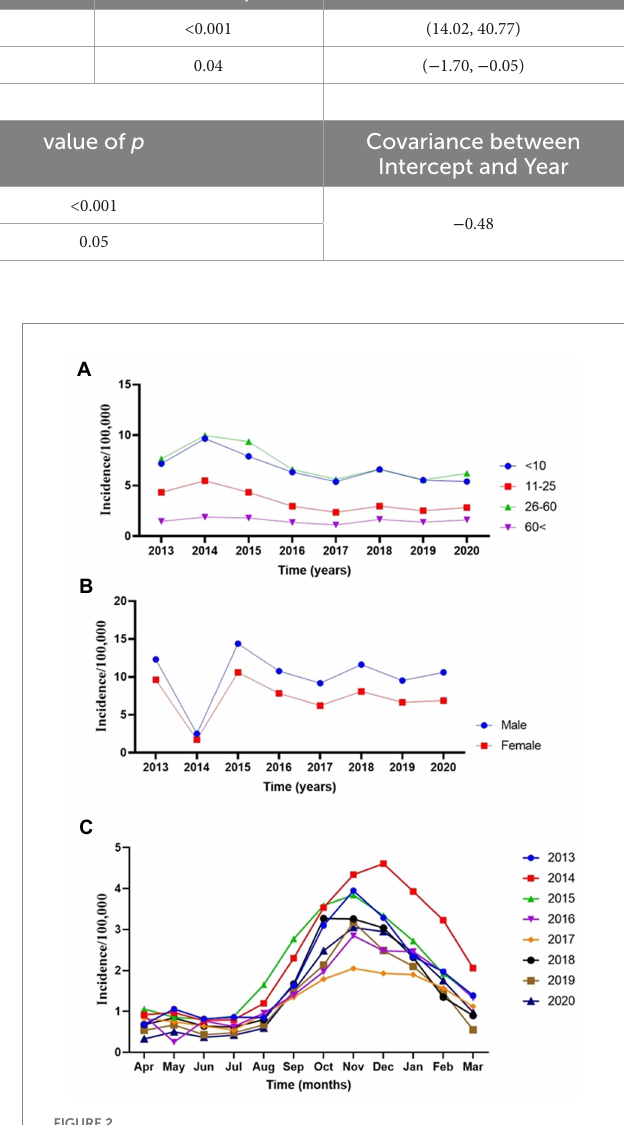
FIGURE 2 The annual incidence trend of cutaneous leishmaniasis in various provinces of Iran, 2013–2020. (A) Age-groups. (B) Sex. (C) Monthly.